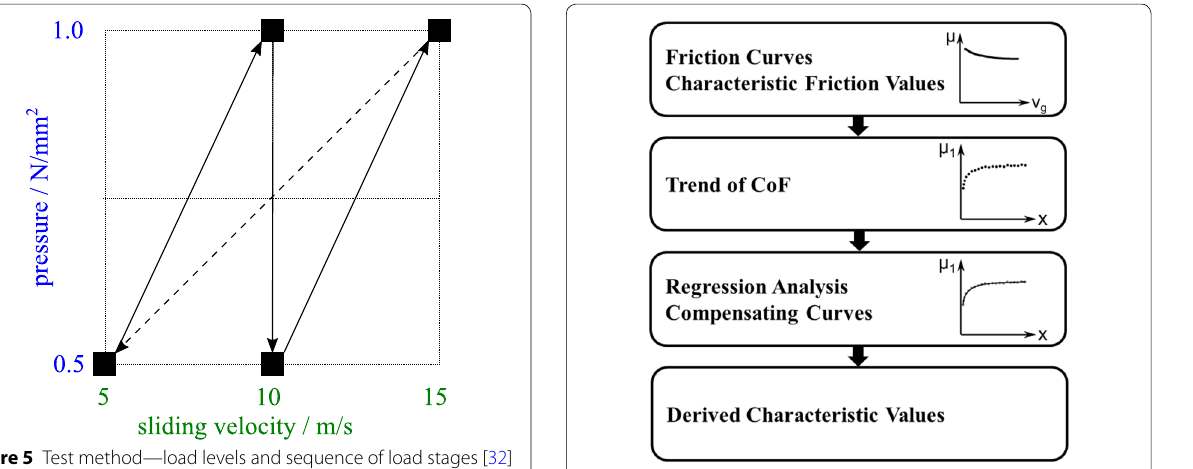
Figure 6 Method for characterization of running-in behavior